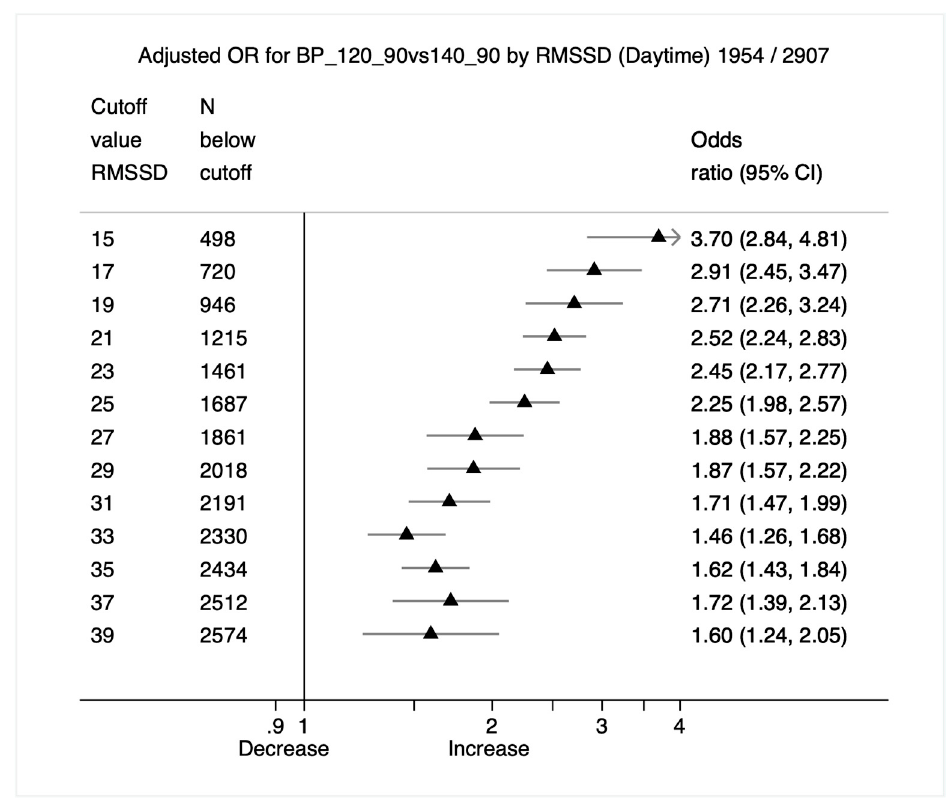
Figure 1. Forest plot: prediction of root mean square of successive di ff erences between normal heartbeats (RMSSD) for hypertension.